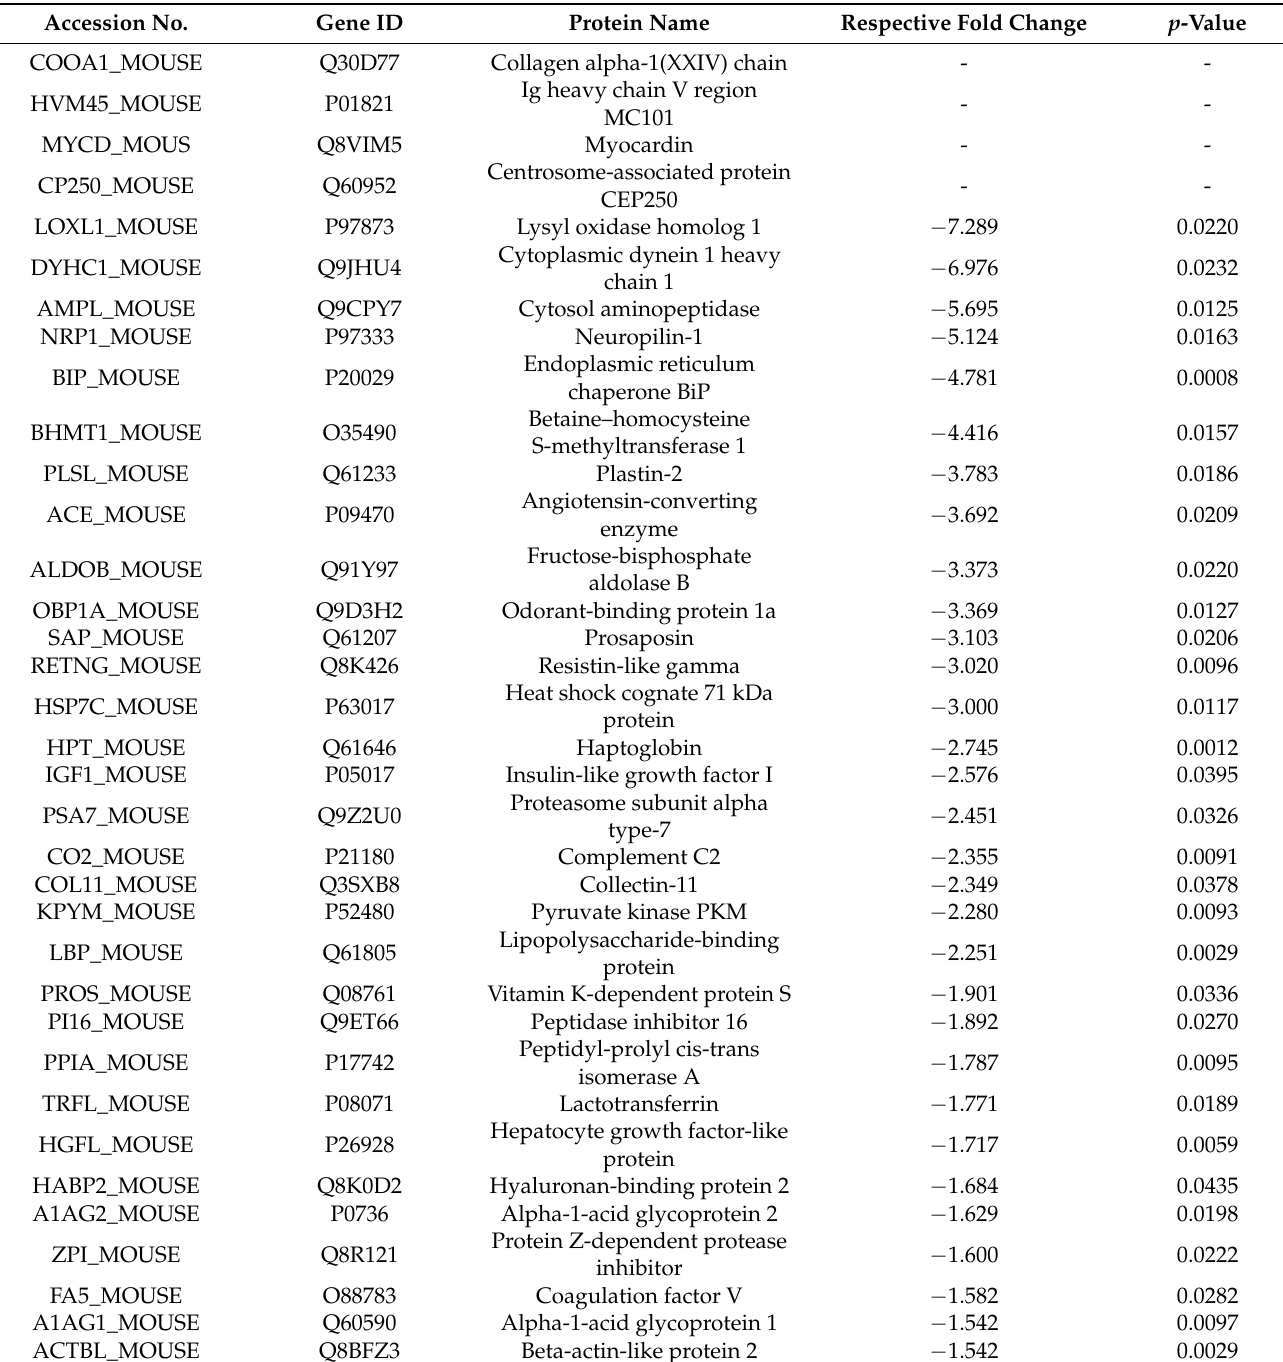
Table 1. The differentially proteins between WD and WD EX